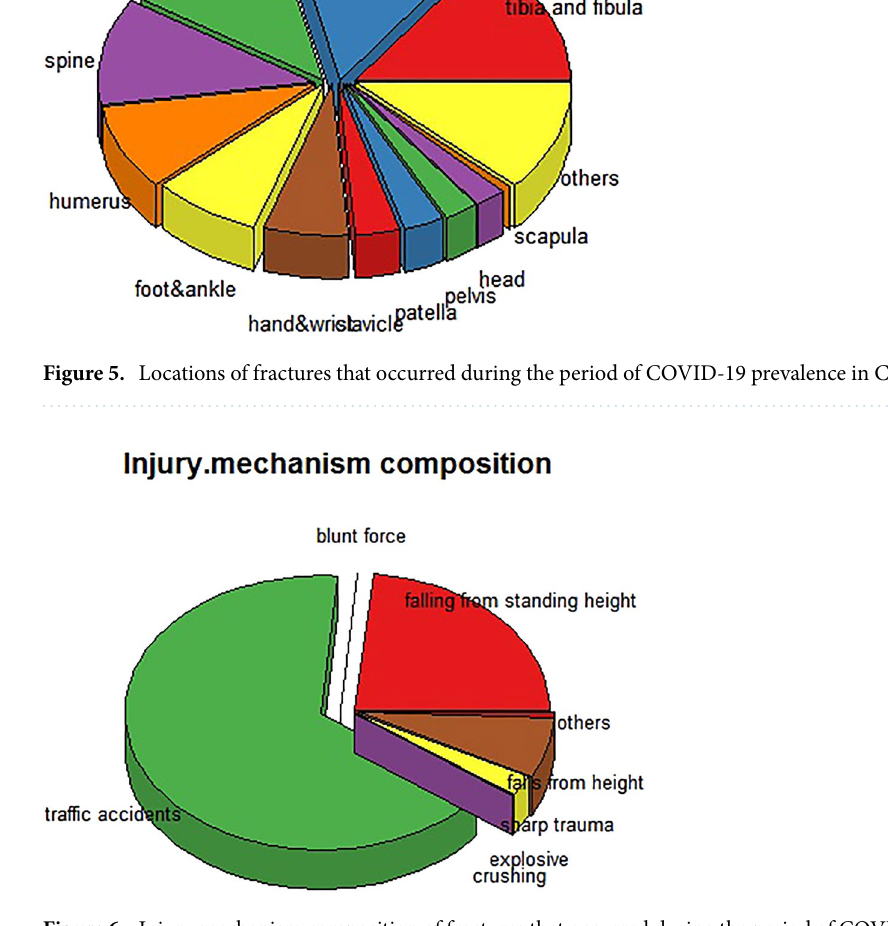
Figure 6. Injury mechanism composition of fractures that occurred during the period of COVID-19 prevalence in